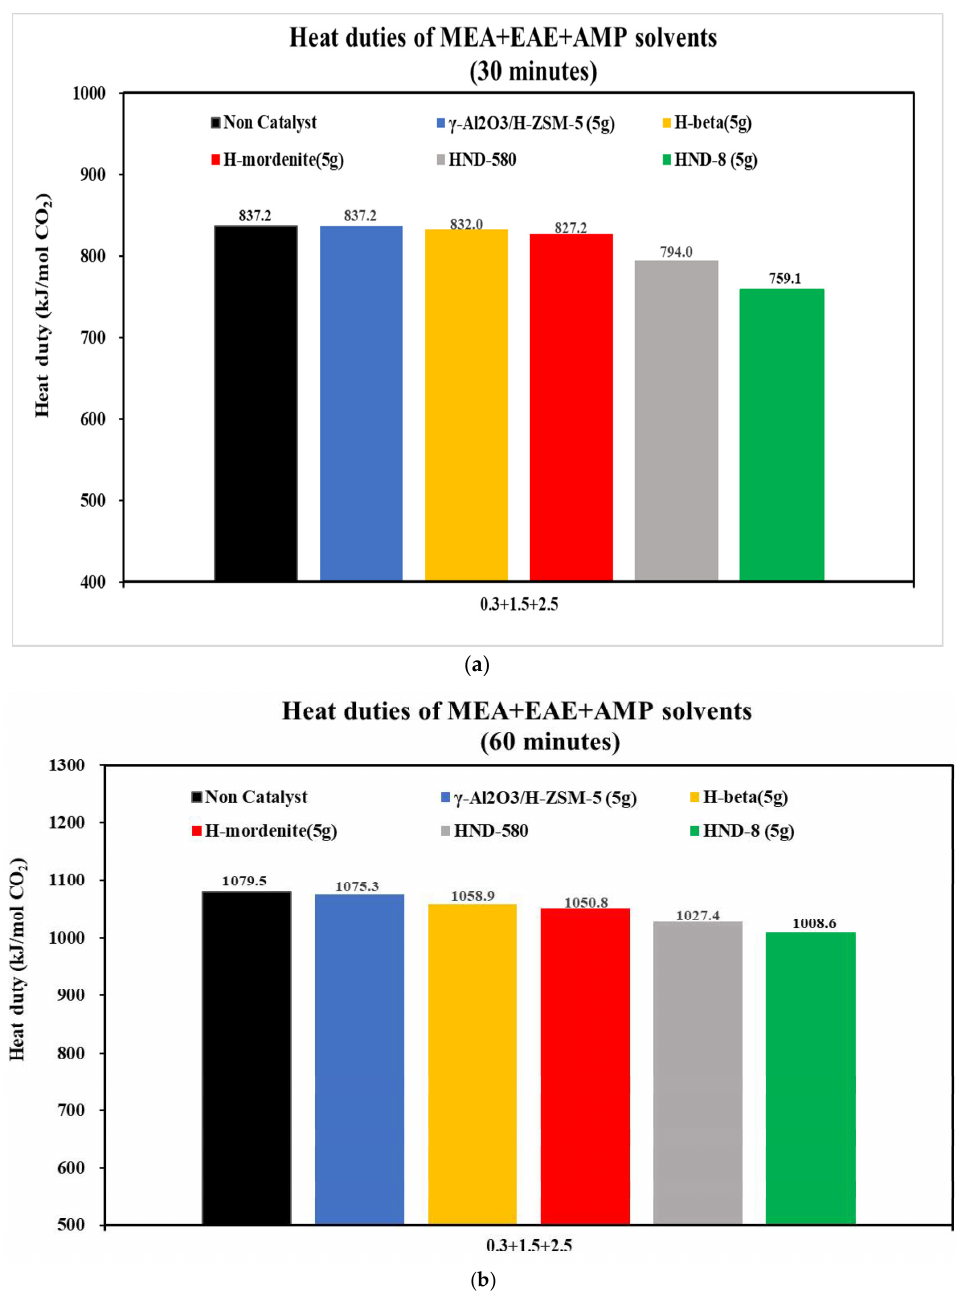
Figure 8. The average desorption rates of MEA + EAE + AMP at 0.3 + 1.5 + 2.5 mol/L with catalysts at ( a ) 30 min, ( b ) 60 min.